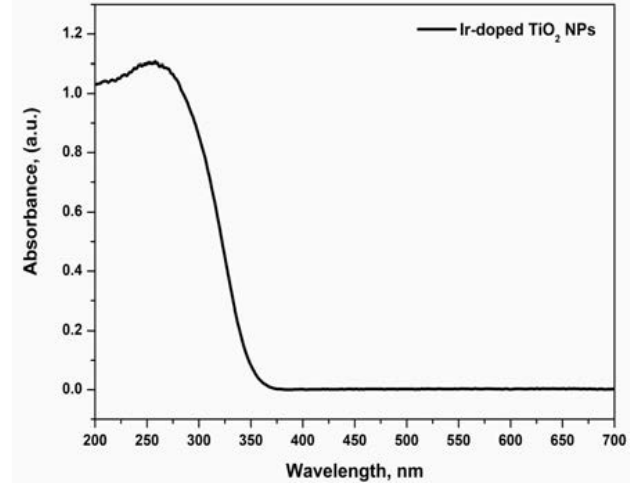
Fig. 1: UV-Vis DRS of Ir-doped TiO